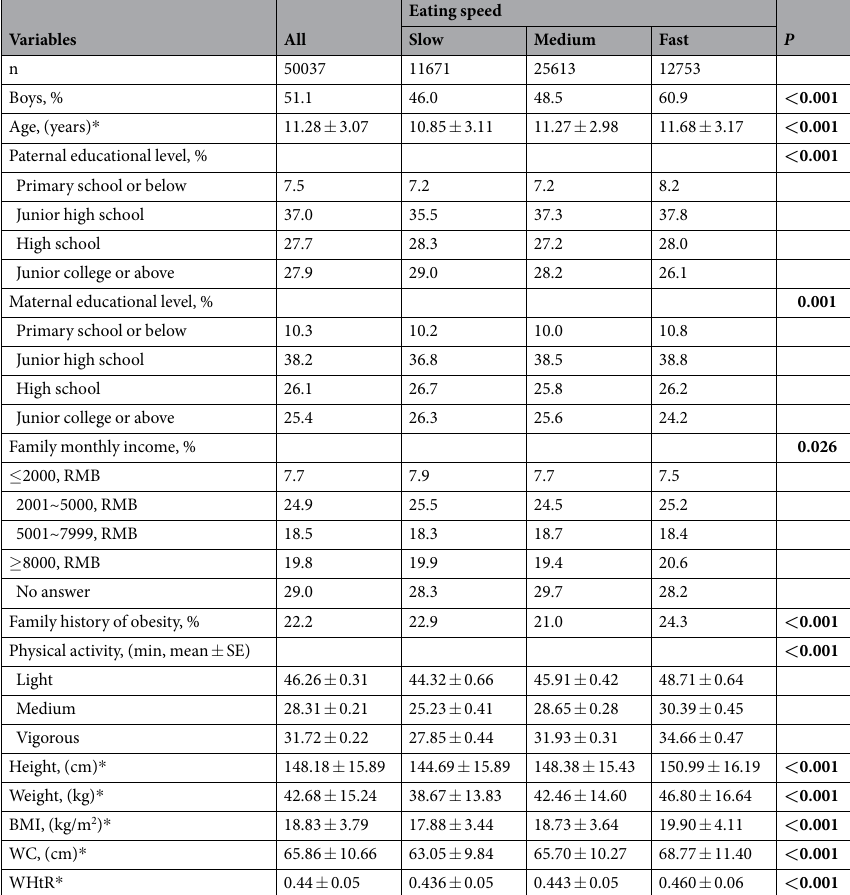
Table 1. Socio-demographic characteristics of participants by eating speed. * Values are shown as mean ± standard deviation. Differences of age across eating speed was tested by using T-test, whereas differences of physical activity time, height, weight, body mass index (BMI), waist circumference (WC) and waist height ratio (WHtR) across different eating speed groups were tested by using analysis of covariance. For categorical variables, differences of gender, parental and maternal educational, family history of obesity and family monthly income between eating speed groups were evaluated by using Pearson Chi-Square